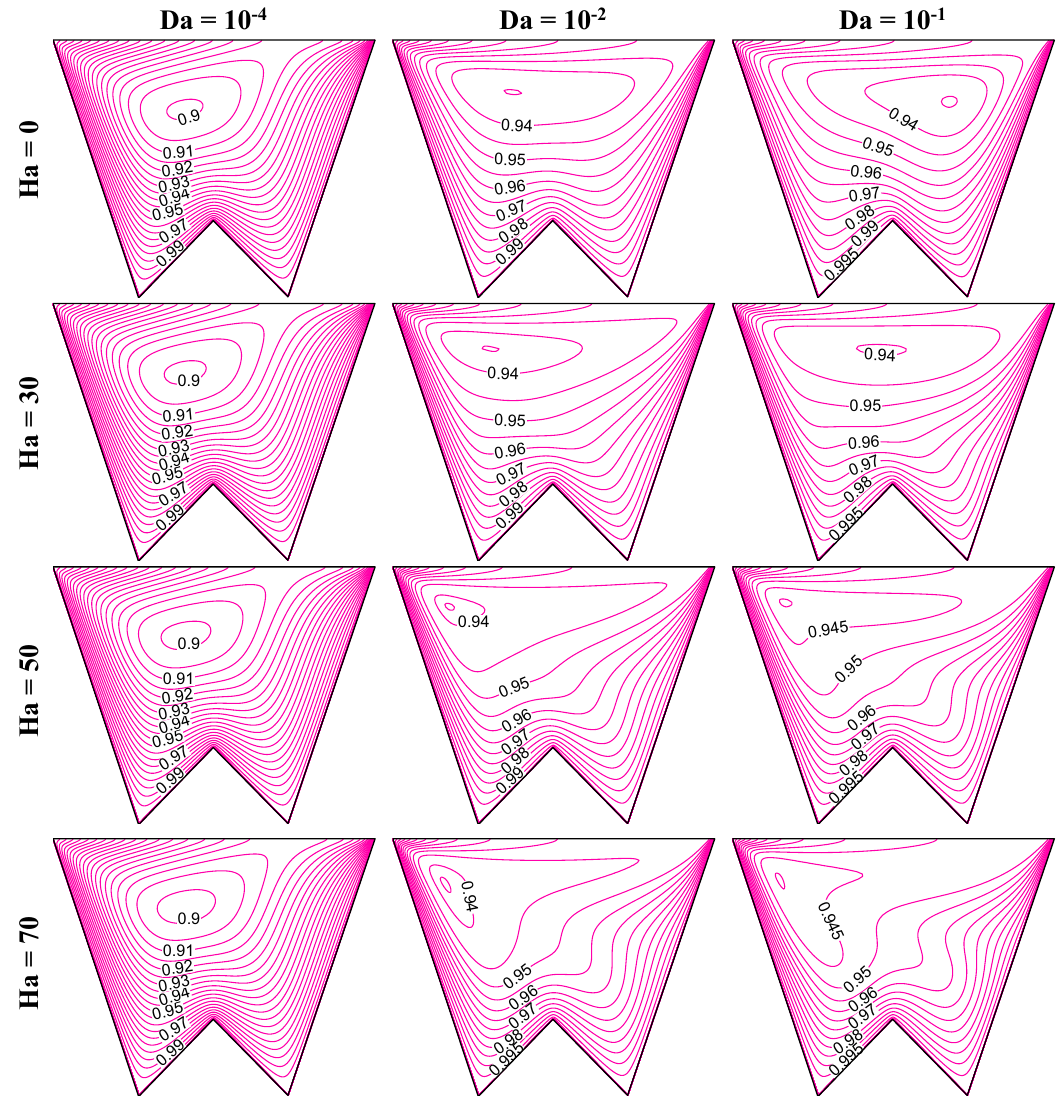
Figure 18. Isoconcentration of microorganisms ( N ) at R b = 50, Le = 1, Pe = 1, Gr = 10 4 , m = 1, δ = 0.3, γ =